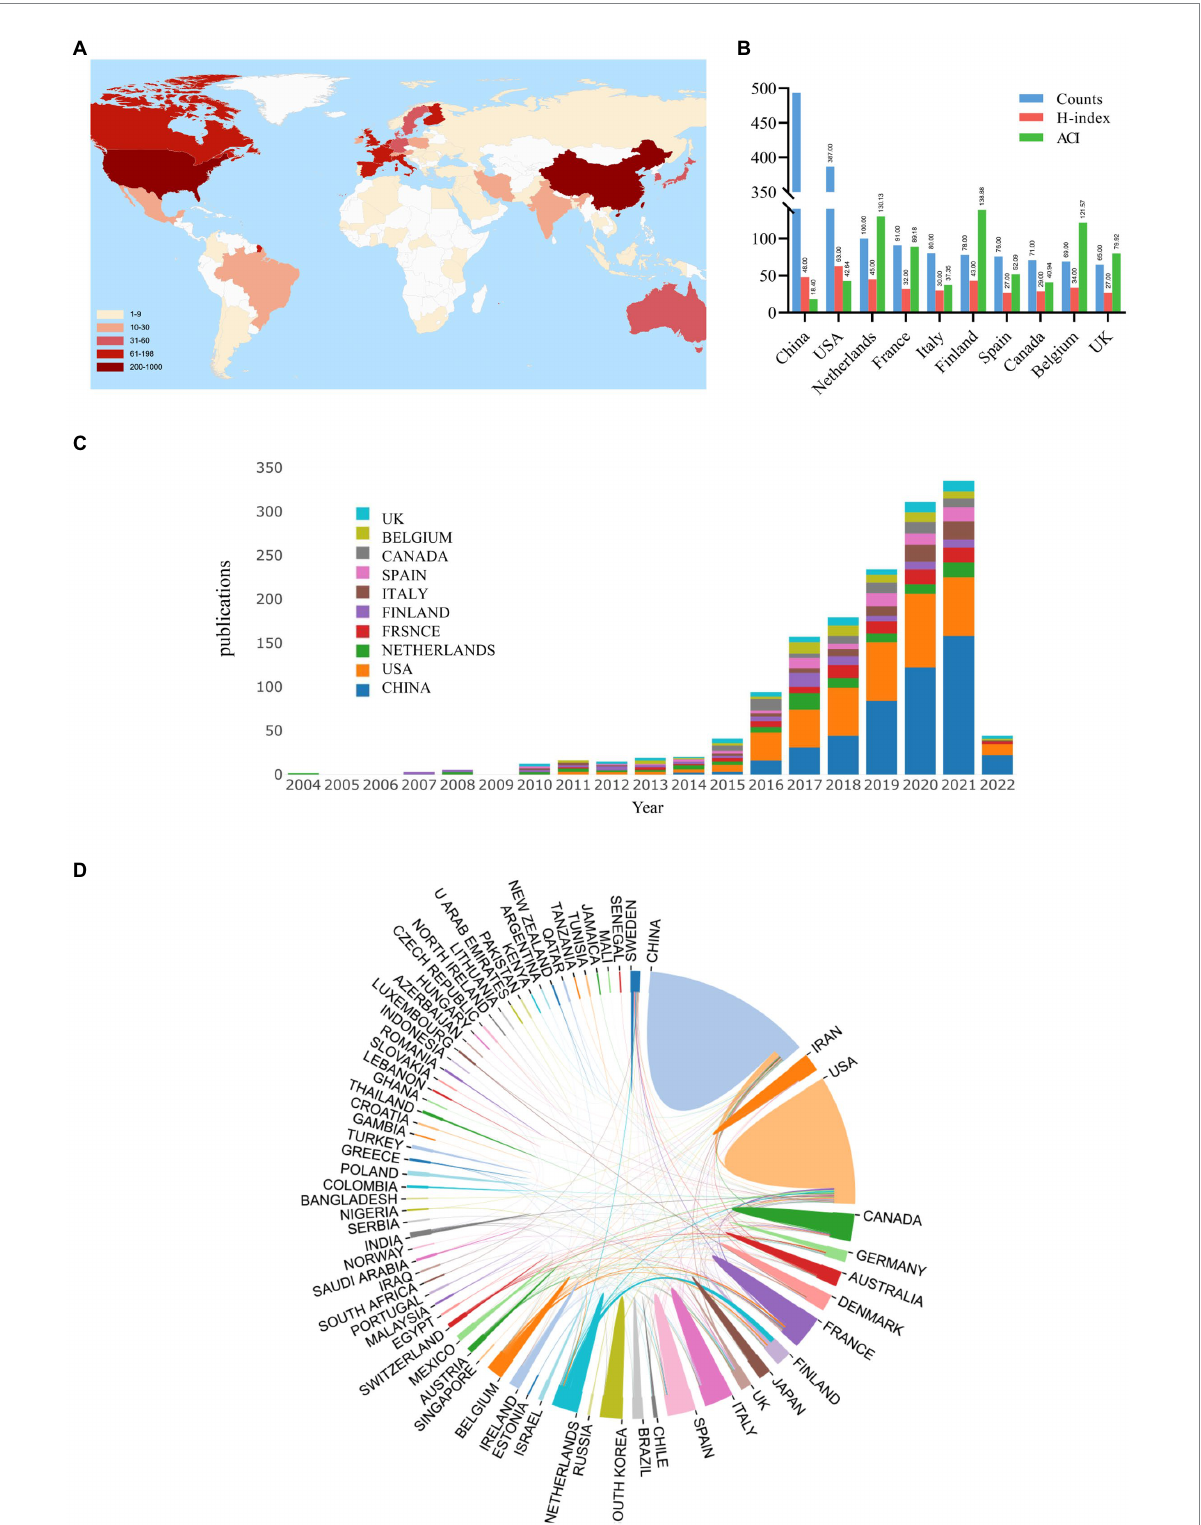
FIGURE 4 Analysis of the contribution of different countries/regions to A. muciniphila research. (A) Geovisualization of A. muciniphila research distribution. Color shades correlate with the number of articles published. England, Northern Ireland, Scotland, and Wales were reclassified together as the United Kingdom; Taiwan was merged into China. (B) The publication counts, H-index, and ACI of the top 10 most productive countries/regions. (C) Trends in A. muciniphila publications from the top 10 countries/regions from 2004 to 2022. The colors represent different countries/regions. (D) Cooperation of countries/regions involved in A. muciniphila research. The proportion of the area correlates to the number of national publications, and the thickness of the line reflects the strength of cooperation between